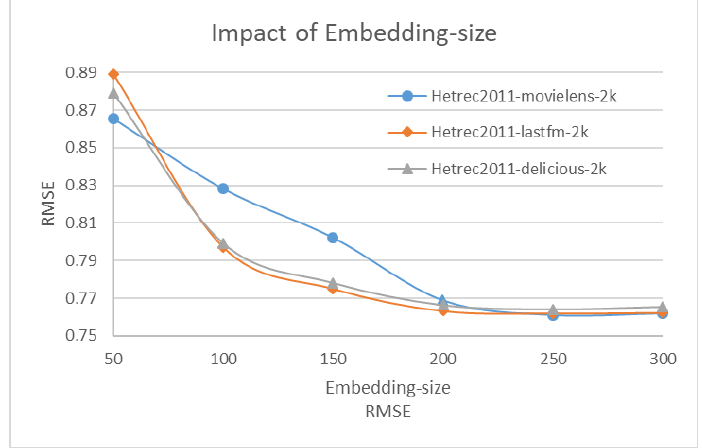
Figure 9. RMSE generated by models with different embedding